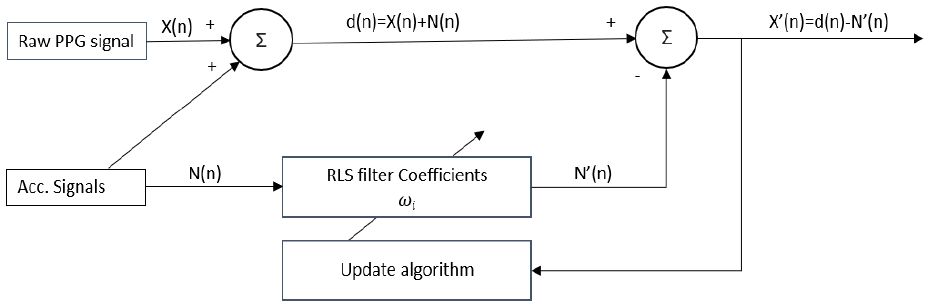
Figure 7. Block diagram of the adopted RLS algorithm.